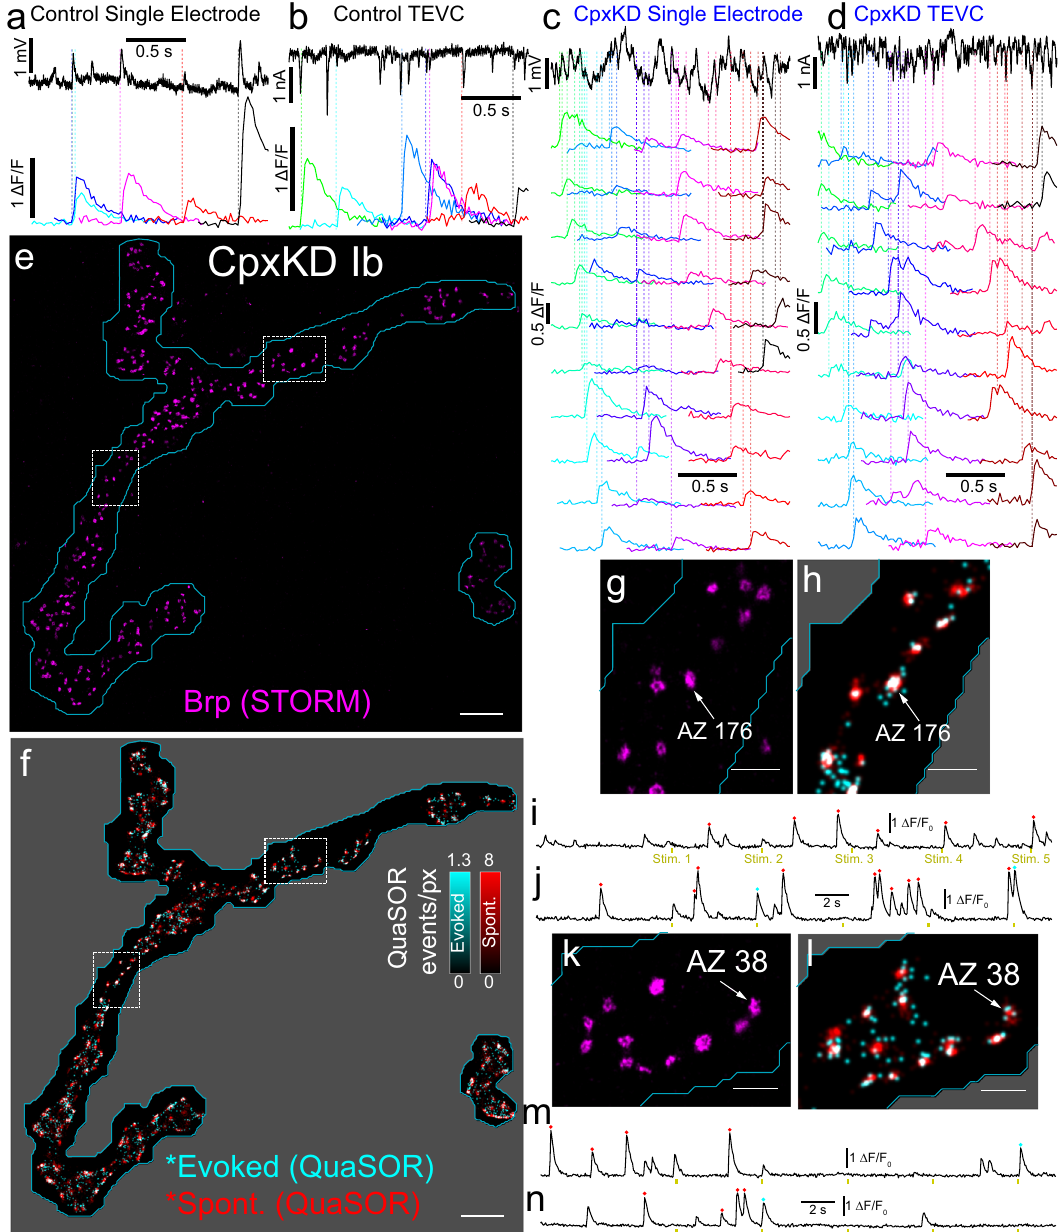
Fig. 6 Analysis of spontaneous and evoked transmission in the knockdown of Cpx. a – d Simultaneous electrophysiological and optical analysis of transmission in Control ( a , b ) and CpxKD ( c , d ) NMJs. Spontaneous events are infrequent enough in control animals to be easily measured electrophysiologically (black traces) as mEPSPs ( a ) and mEPSCs ( b ) and to identify corresponding optical events at identi fi ed synapses (colored traces). In CpxKD animals, the frequency of spontaneous mEPSPs ( c ) and mEPSCs (d ) (black traces) is too high to measure electrophysiological events accurately, but optical events at individual synapses occur infrequently enough to measure easily (colored traces). e Brp 3D-STORM z -projection image for a CpxKD Ib NMJ (OK6-Gal4, UAS-Cpx RNAi , SynapGCaMP6f). f CpxKD QuaSOR map including evoked (cyan) and spontaneous (red) events ( σ = 42.3 nm) aligned to 3D-STORM area in e . g – n Two magni fi ed Ib boutons from ROIs shown in dashed squares in f , each with a single example AZ ( g , h , AZ 176 and k , l , AZ 38) and its corresponding QuaSOR traces ( i , j for AZ 176 and m , n for AZ 38). The QuaSOR traces mark evoked (cyan dots) and spontaneous (red dots) transmission events. Unmarked events were generated at other neighboring sites. Stimulus times are indicated below the traces. Scale bars: 5 µ m ( e , f ), 1 µ m ( g , h , k , l